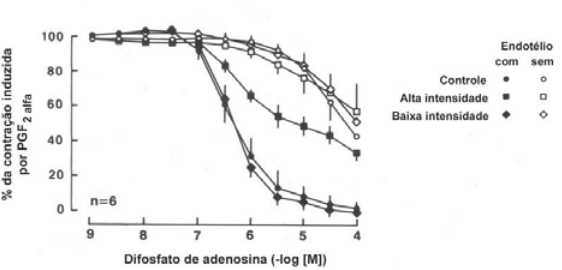
Fig. 3 - Relaxamento dependente do endotélio induzido por difosfato de adenosina (ADP) em artérias coronárias caninas. As artérias foram expostas à baixa ou alta intensidade de energia ultra-sônica e contraídas com prostaglandina F (PGF ). Quando a 2 α 2 α contração induzida pela PGF estabilizou, as artérias foram 2 α submetidas a concentrações crescentes de ADP. Os dados estão apresentados como médias ± erro padrão médio e observaram-